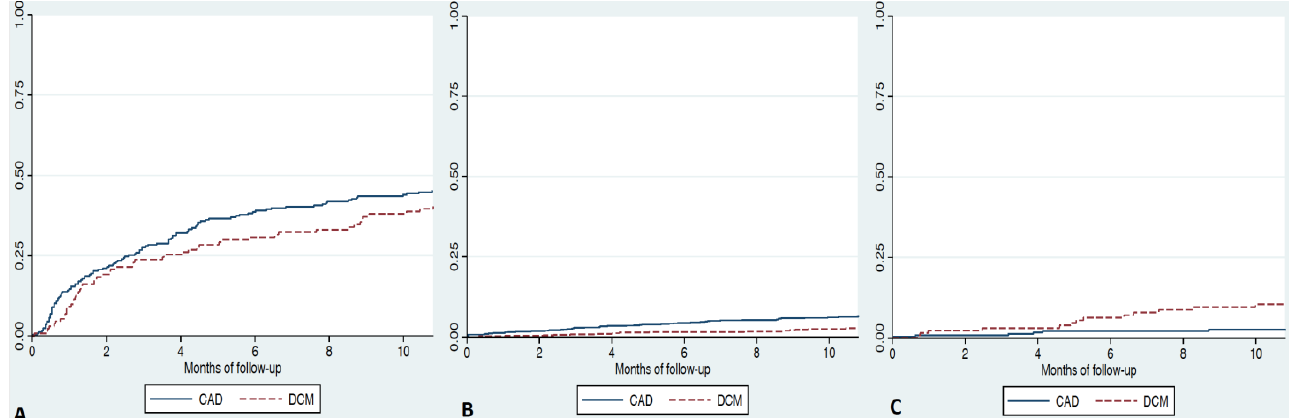
Figure 1. Adjusted Kaplan–Meier curves in patients admitted due to heart failure divided in three groups: idiopathic dilated cardiomyopathy (DCM), coronary artery disease (CAD)-ischemic. ( A ) Com- bined endpoint of death/heart failure readmission. ( B ) All-cause death. ( C ) Heart transplantation.